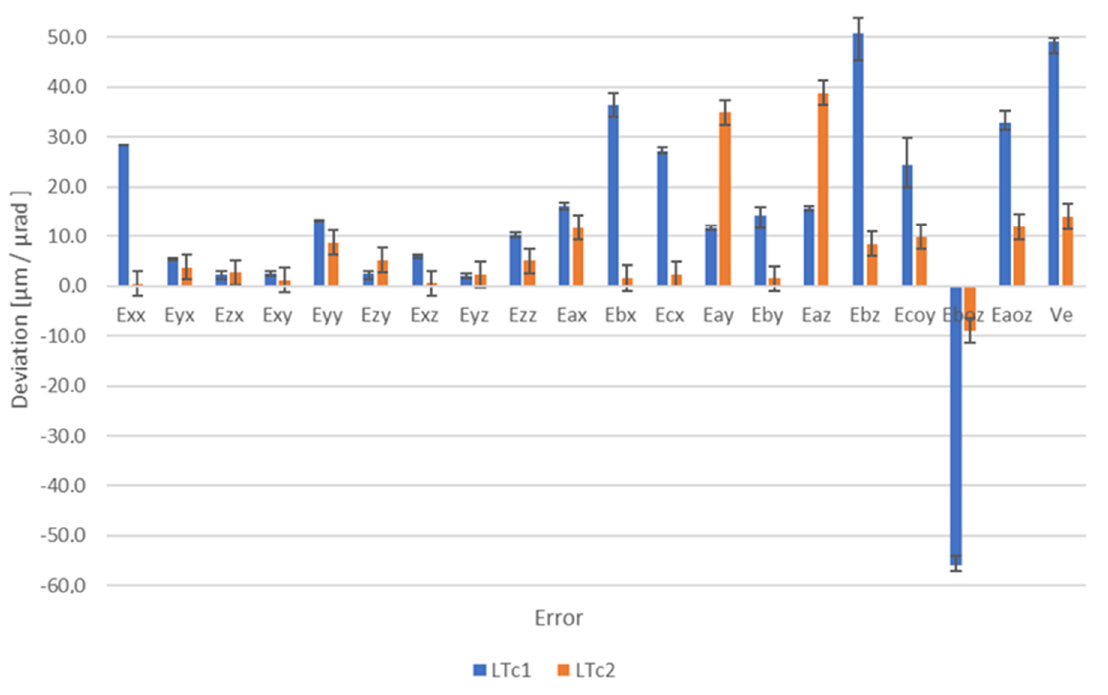
Figure 6. Geometric errors calculated with the help of volumetric accuracy measurements.